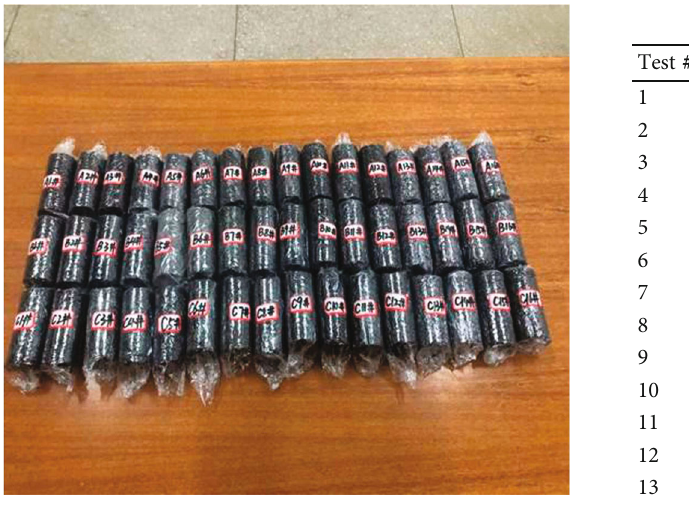
Figure 2: The specimen of triaxial text.